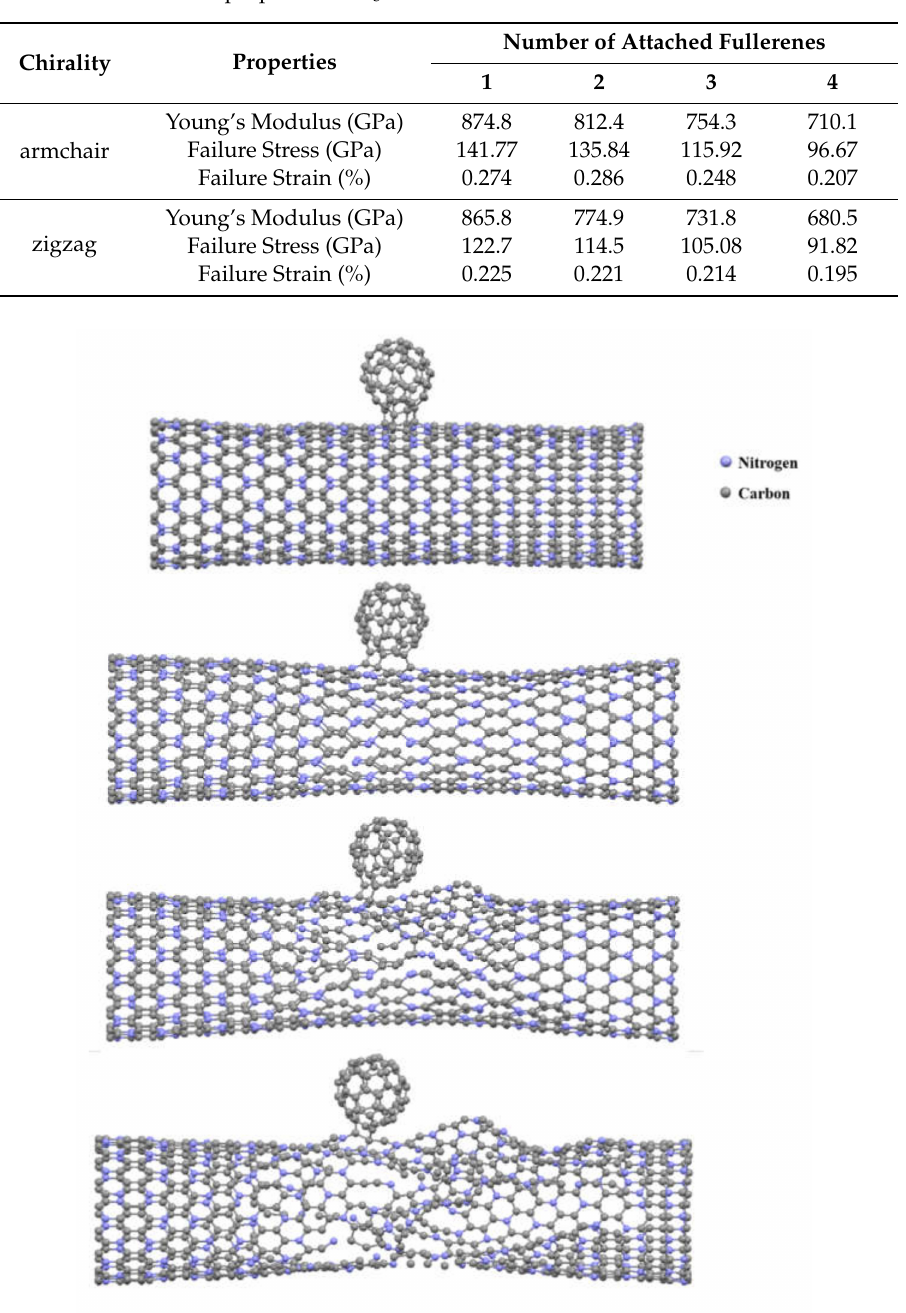
Figure 11. Snapshot of the failure process of a (18,0)-1C 60 C 3 N